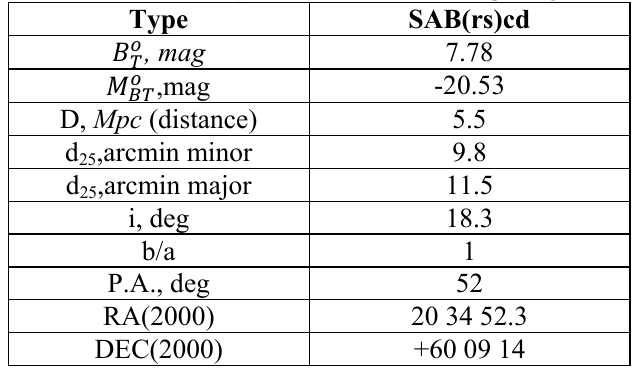
Table 1: Basic parameters of studied